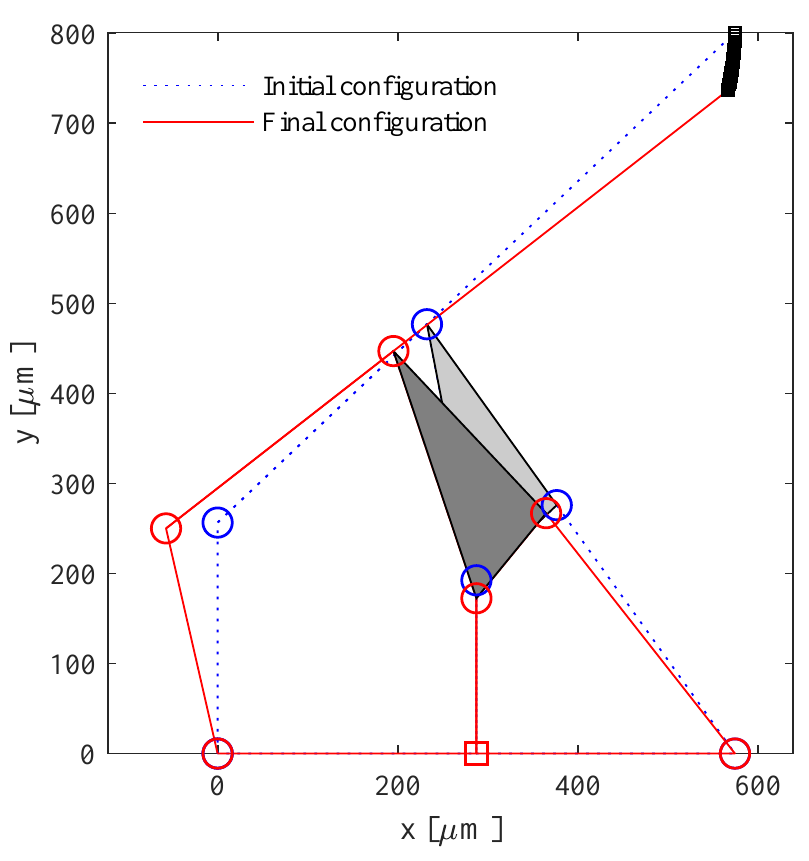
Figure 8. Initial and final configurations, corresponding to ∆ u = 0 and ∆ u = − 20 µ m,